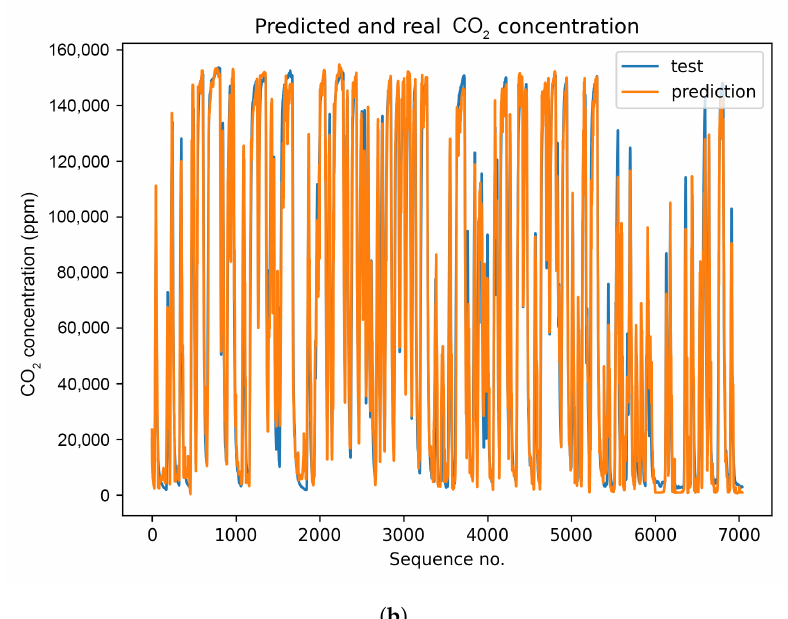
Figure 9. Vehicle onboard deployment. ( a ) Setup. ( b ) Prediction against real recorded